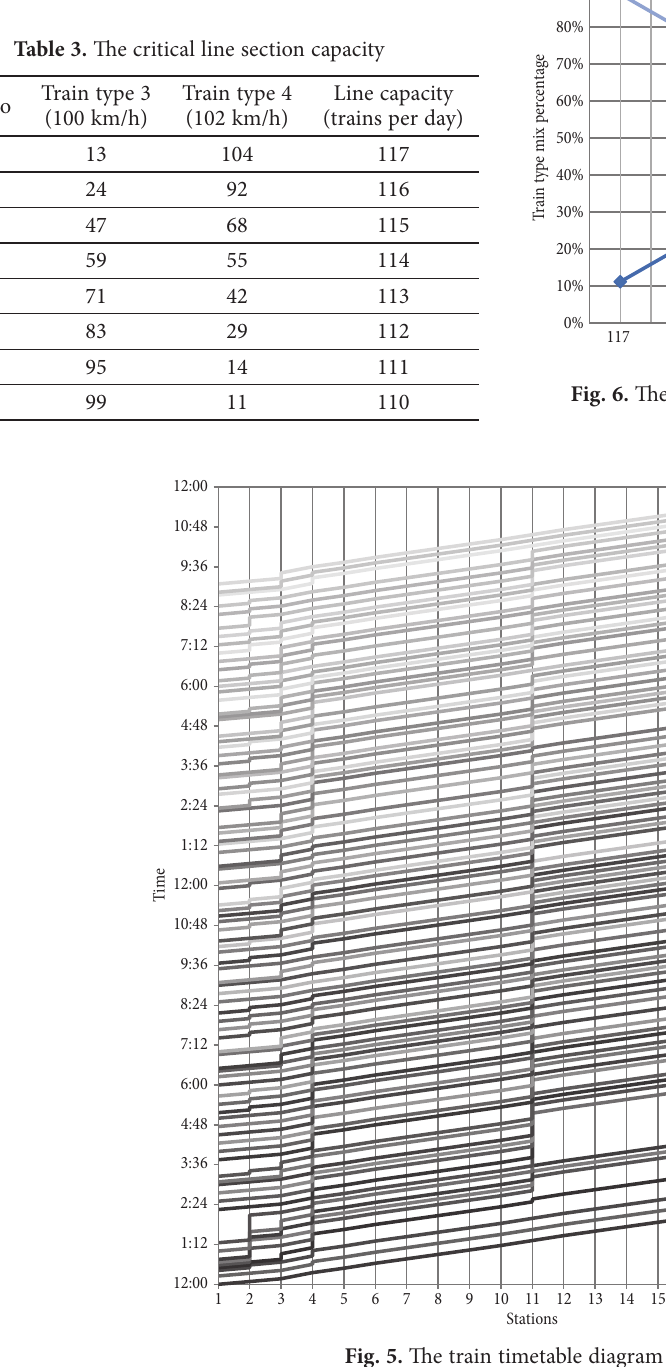
Fig. 5. The train timetable diagram